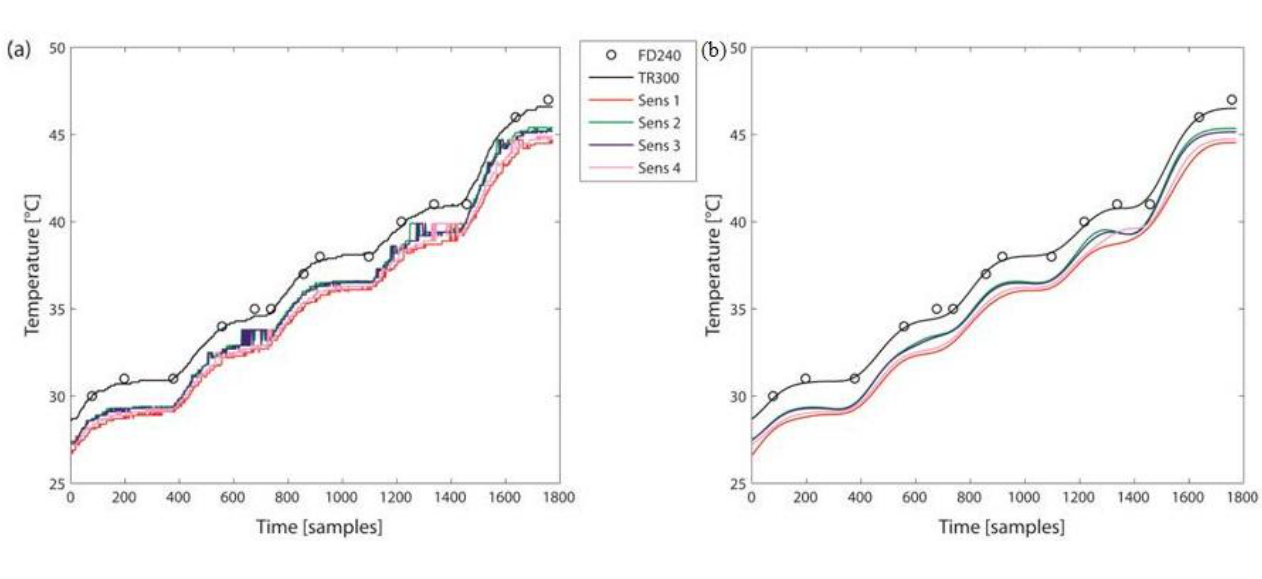
Figure 2. Example of ( a ) temperature raw data; and ( b ) temperature data after